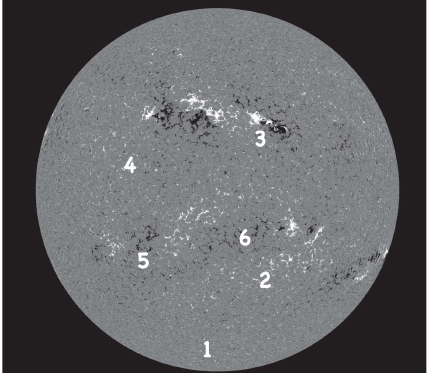
Figure 3. A typical map of the line-of-sight magnetic field in the so- lar photosphere. The bright regions represent the magnetic field that is directed towards you, while the dark regions have magnetic fields pointing away. The numbers indicate (1) the polar field, (2) a large- scale unipolar field, (3) an active region, (4) a tiny bipolar region (called an ephemeral region and a normal network), (5) a remnant active region (6) and an enhanced network field. The two sunspot bands north and south of the equator can clearly be seen (from the HMI instrument on the Solar Dynamics Observatory, SDO).